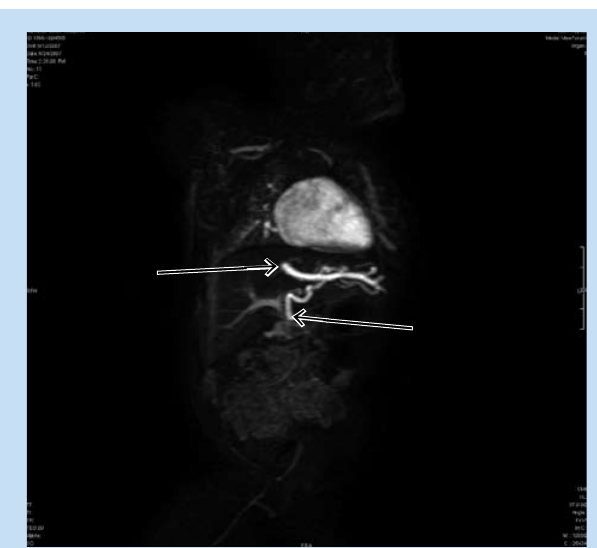
Fig. 3. Coronal MIP image from contrast-enhanced MRA study. The dominant arterial supply from the abdominal aorta and left hepatic artery are shown (arrows).